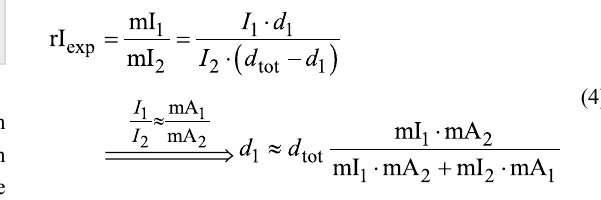
detected at positions where both twin crystallites overlap in projection. In Figure 1c the matched simulated diffraction pattern of both twin crystallites are overlaid and their unique diffraction spots are highlighted in the corresponding